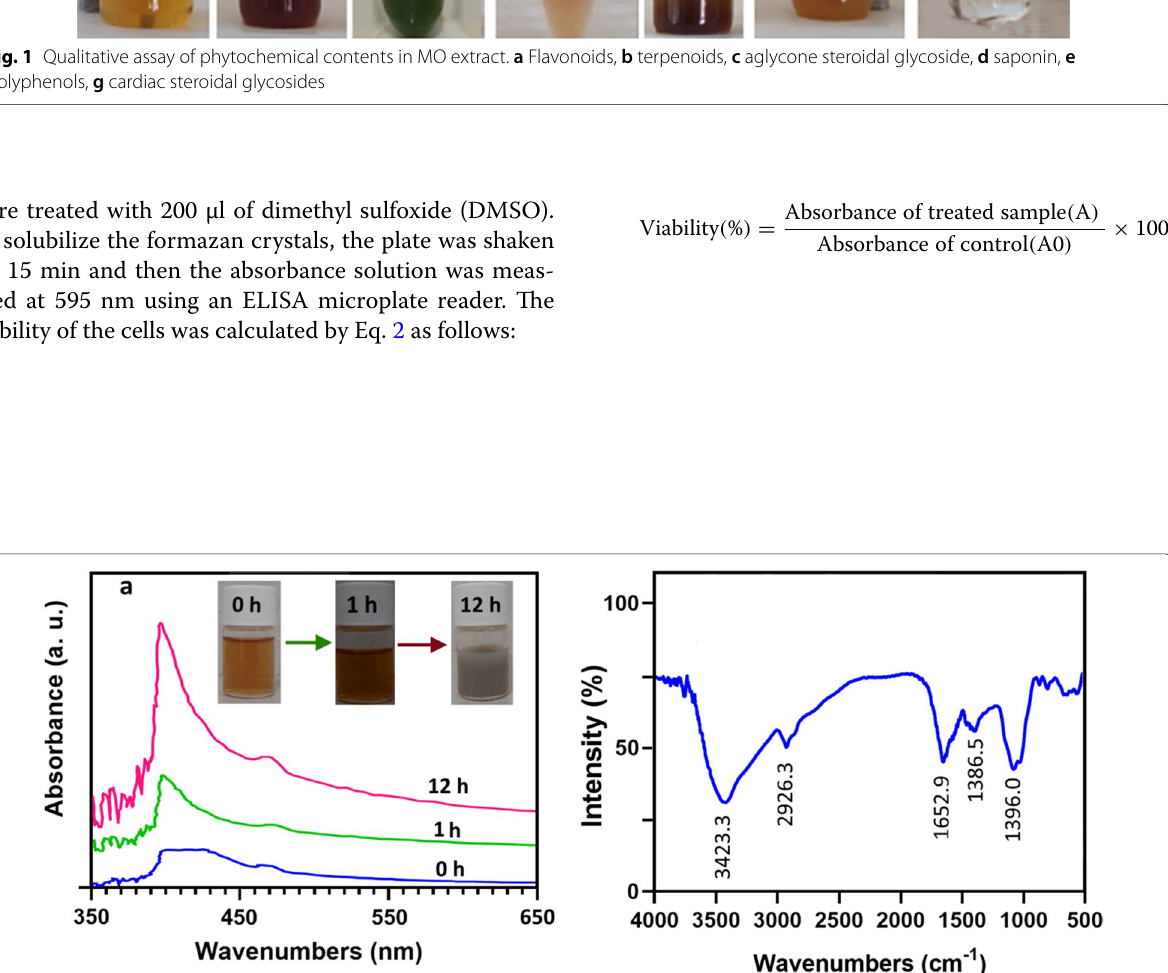
Fig. 2 a UV–visible absorption and b FTIR spectra of Ag 2